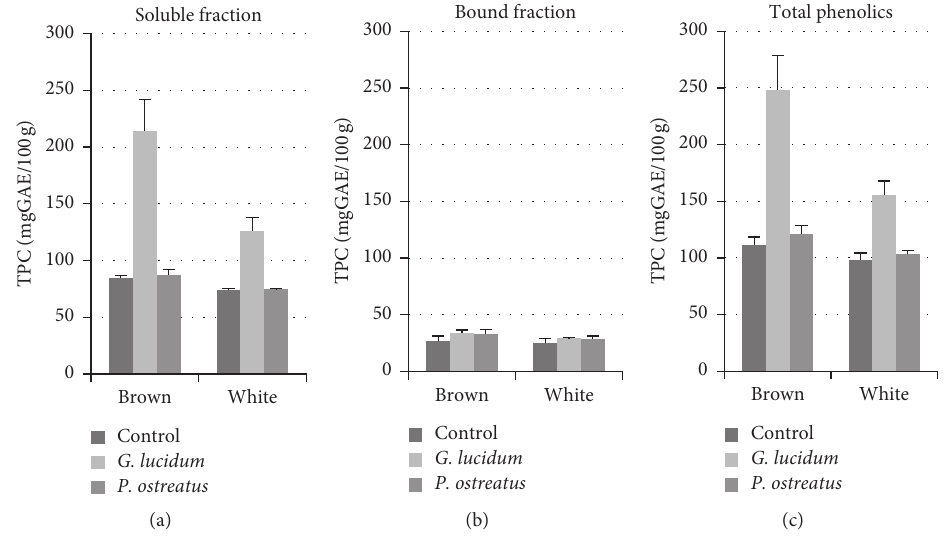
Figure 1: Changes in phenolic contents in teff grain samples after mushroom mycelia-based solid-state fermentation.